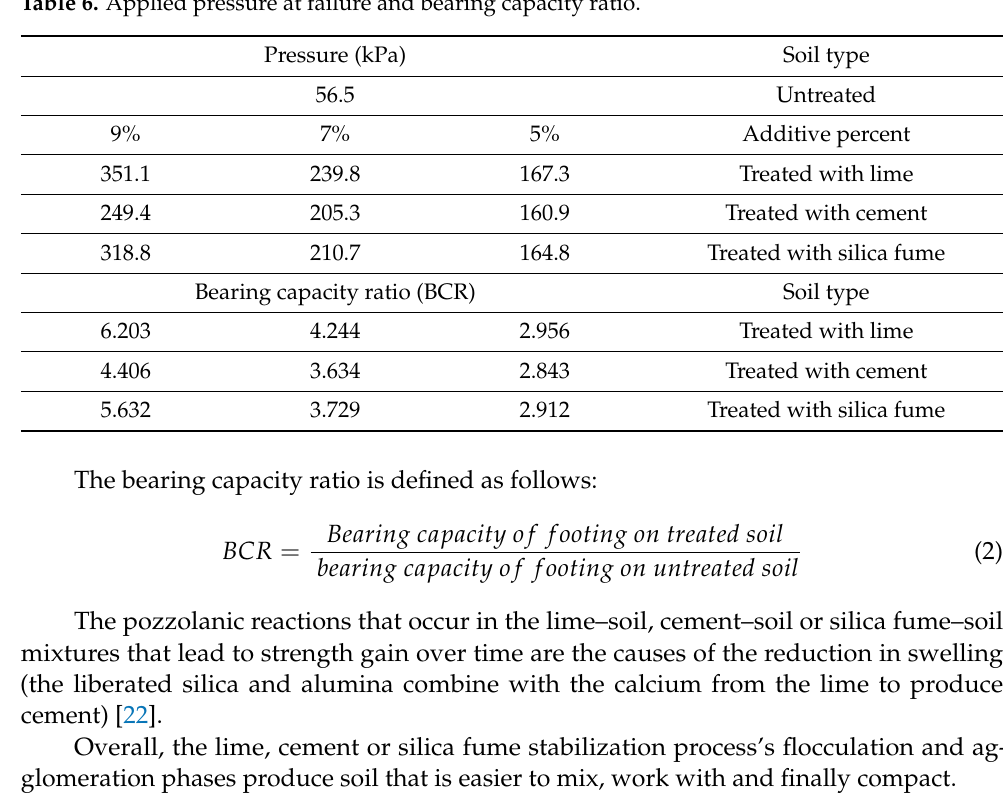
Figure 11. Pressure – settlement relationship for soil grouted with silica fume. Figure 11. Pressure–settlement relationship for soil grouted with silica fume. Table 6. Applied pressure at failure and bearing capacity